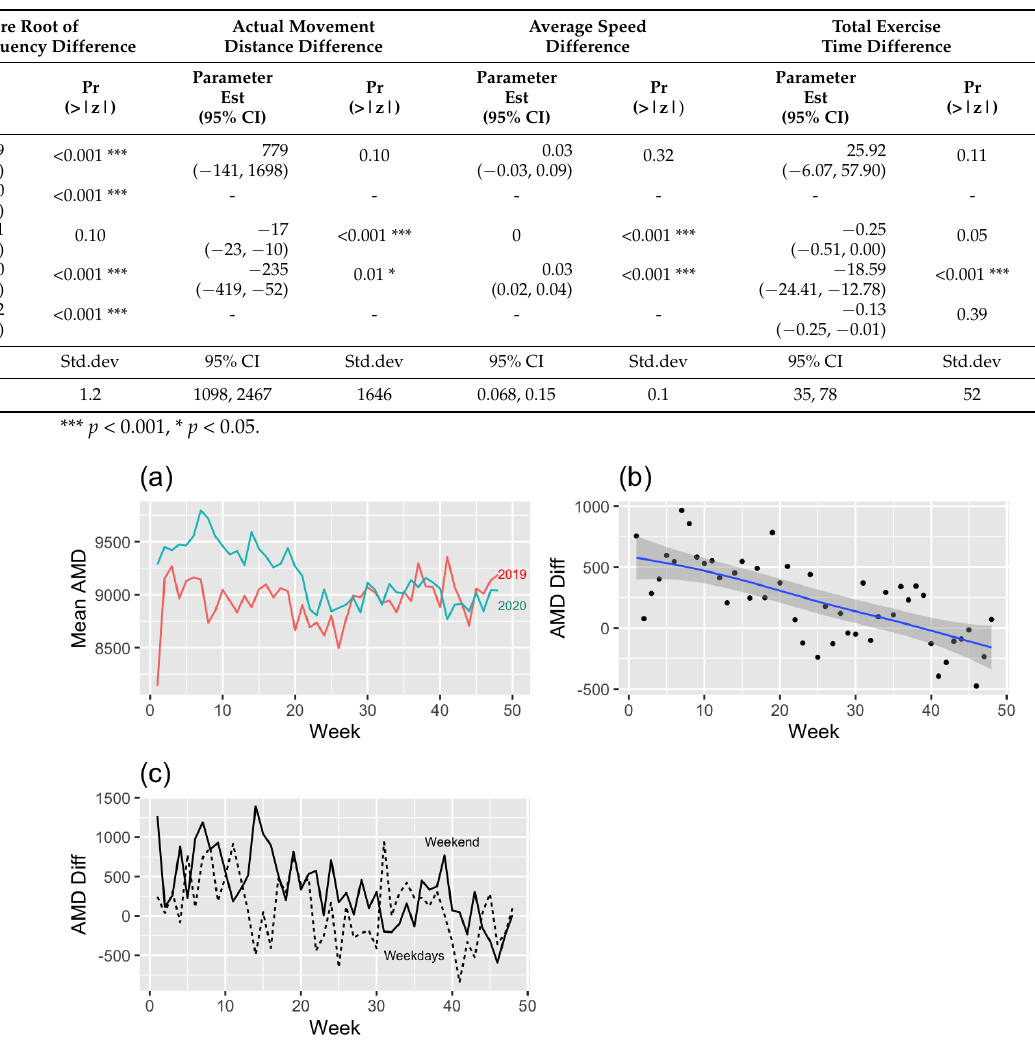
Table 2. Estimated regression coefficients with their 95% confidence intervals and p -values of the linear mixed model.